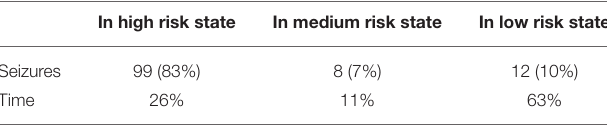
TABLE 3 | Forecast results based on electrographic